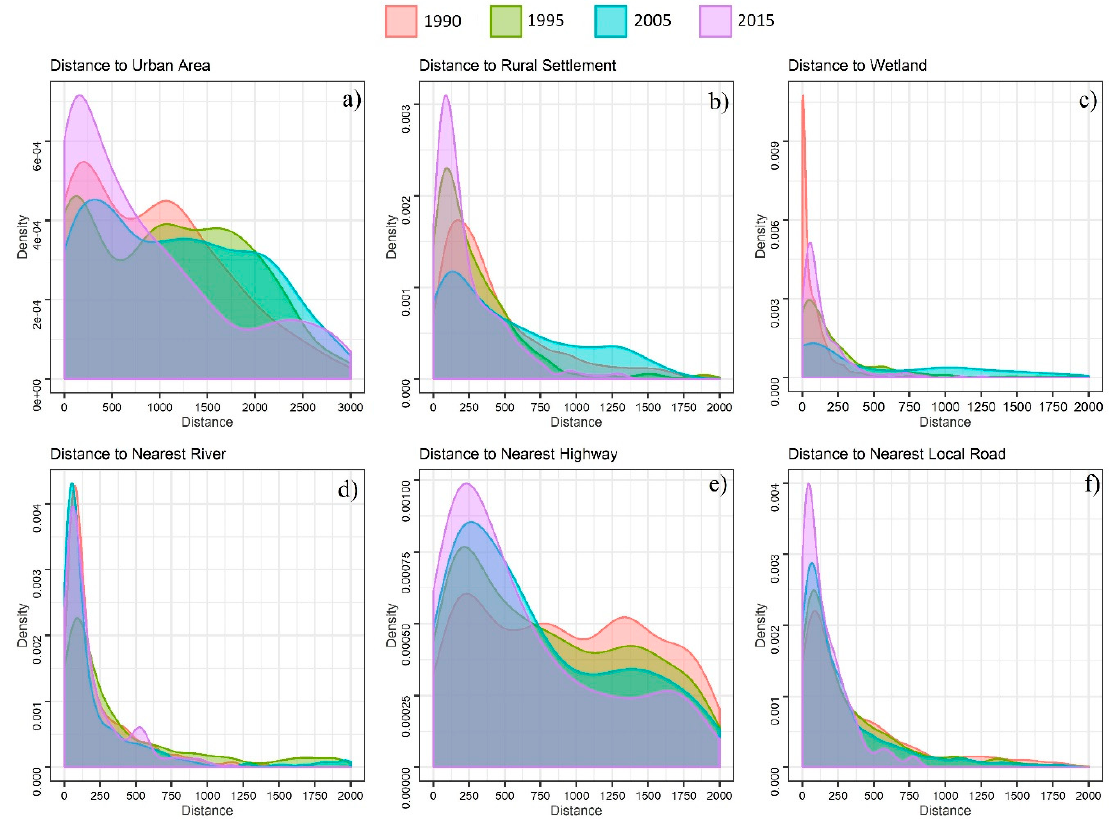
Figure 7. Nearest neighbor distances between brickfields and urban areas ( a ), rural settlements ( b ), wetlands ( c ), rivers ( d ), highways ( e ), and local roads ( f ) plotted as density functions. Distance on the horizontal axes are indicated in meters, and vertical axes represent bandwidth along with the peak of a density where values are concentrated over the interval.